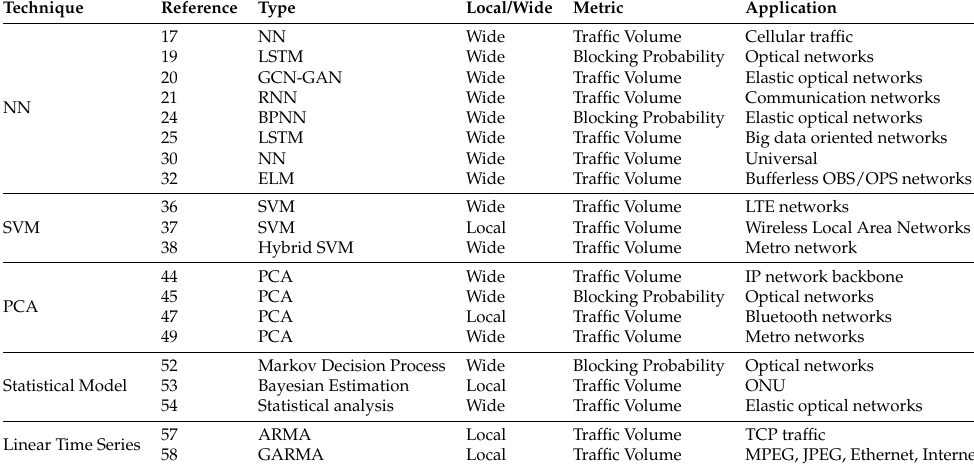
Table 1. List of papers on short-term communication traffic prediction.